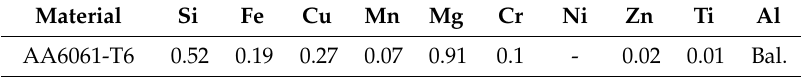
Table 1. Chemical composition (wt %) of the material.